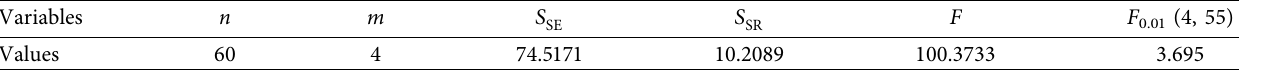
Table 5: Summary of variables of the significance test.